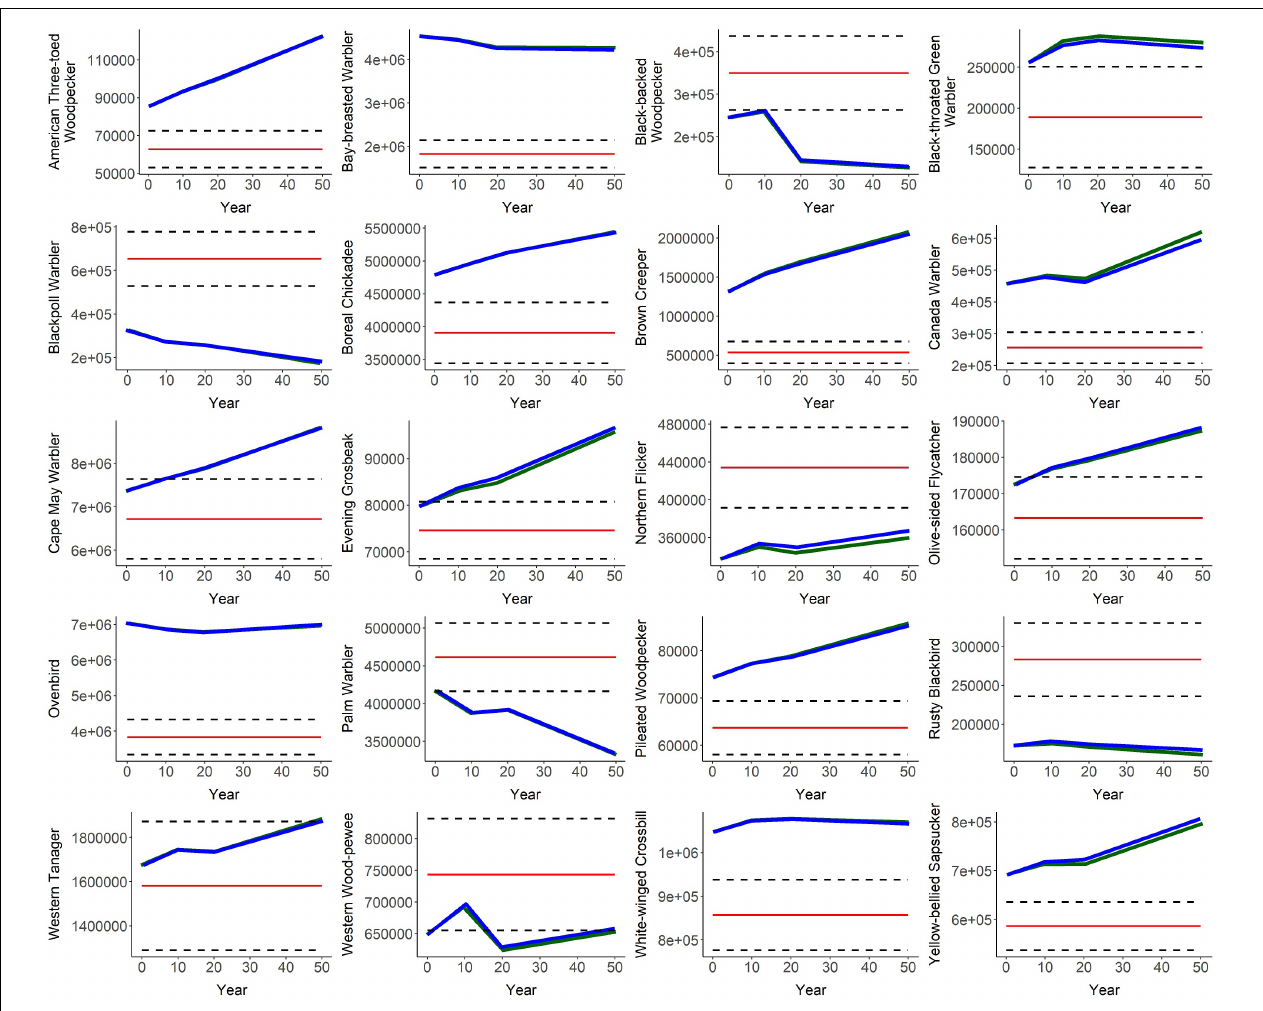
FIGURE 4 | Predicted abundance of 20 boreal bird over time (year 0–50, where year 0 = 2016) in the Al-Pac Forest Management Area (FMA), under two scenarios: (1) the Preferred Forest Management Scenario (PFM) that included harvest deferral within caribou habitats (green line); and (2) the Ecosystem-Based Management/Natural Disturbance Model Scenario (EBM) without harvest deferral (blue), relative to the predicted Natural Range of Variation (NRV) in abundance of each species in the absence of human footprint. Red line = mean predicted abundance in the FMA in the NRV Scenario. Black dashed lines = 95% confidence interval estimates in the NRV